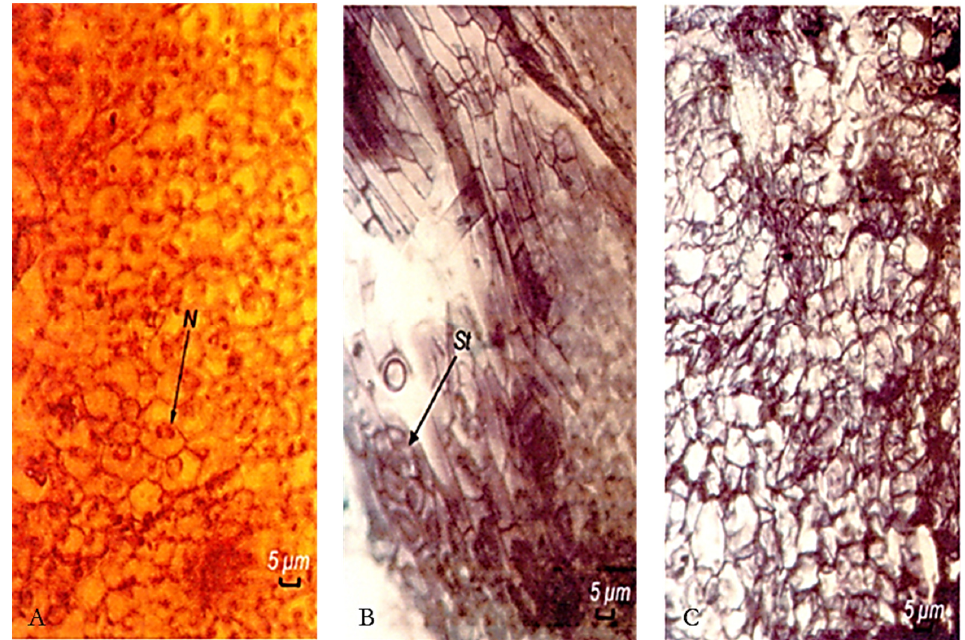
Figure 3. Microscopic observations of control callus tissues from different genotypes, obtained after 4 weeks of culture on an MS